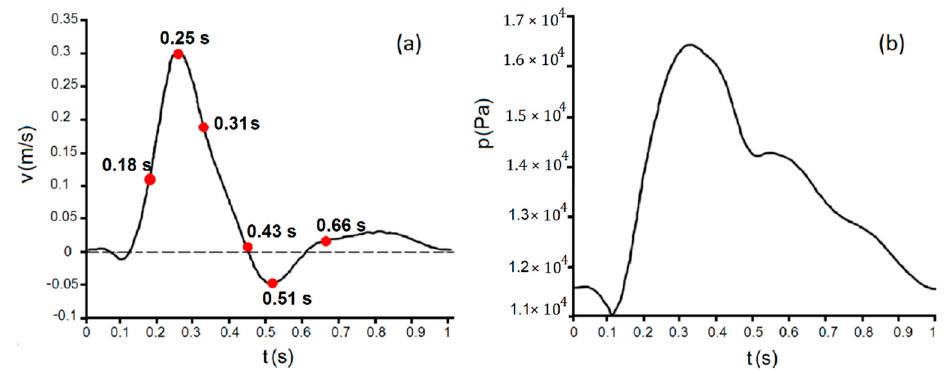
Figure 2. ( a ) Pulsatile velocity waveform assigned at the inlet of the model, ( b ) pressure waveform assigned at the outlets of the model. Red points indicate the instants of the cardiac cycle selected for the numerical investigation.